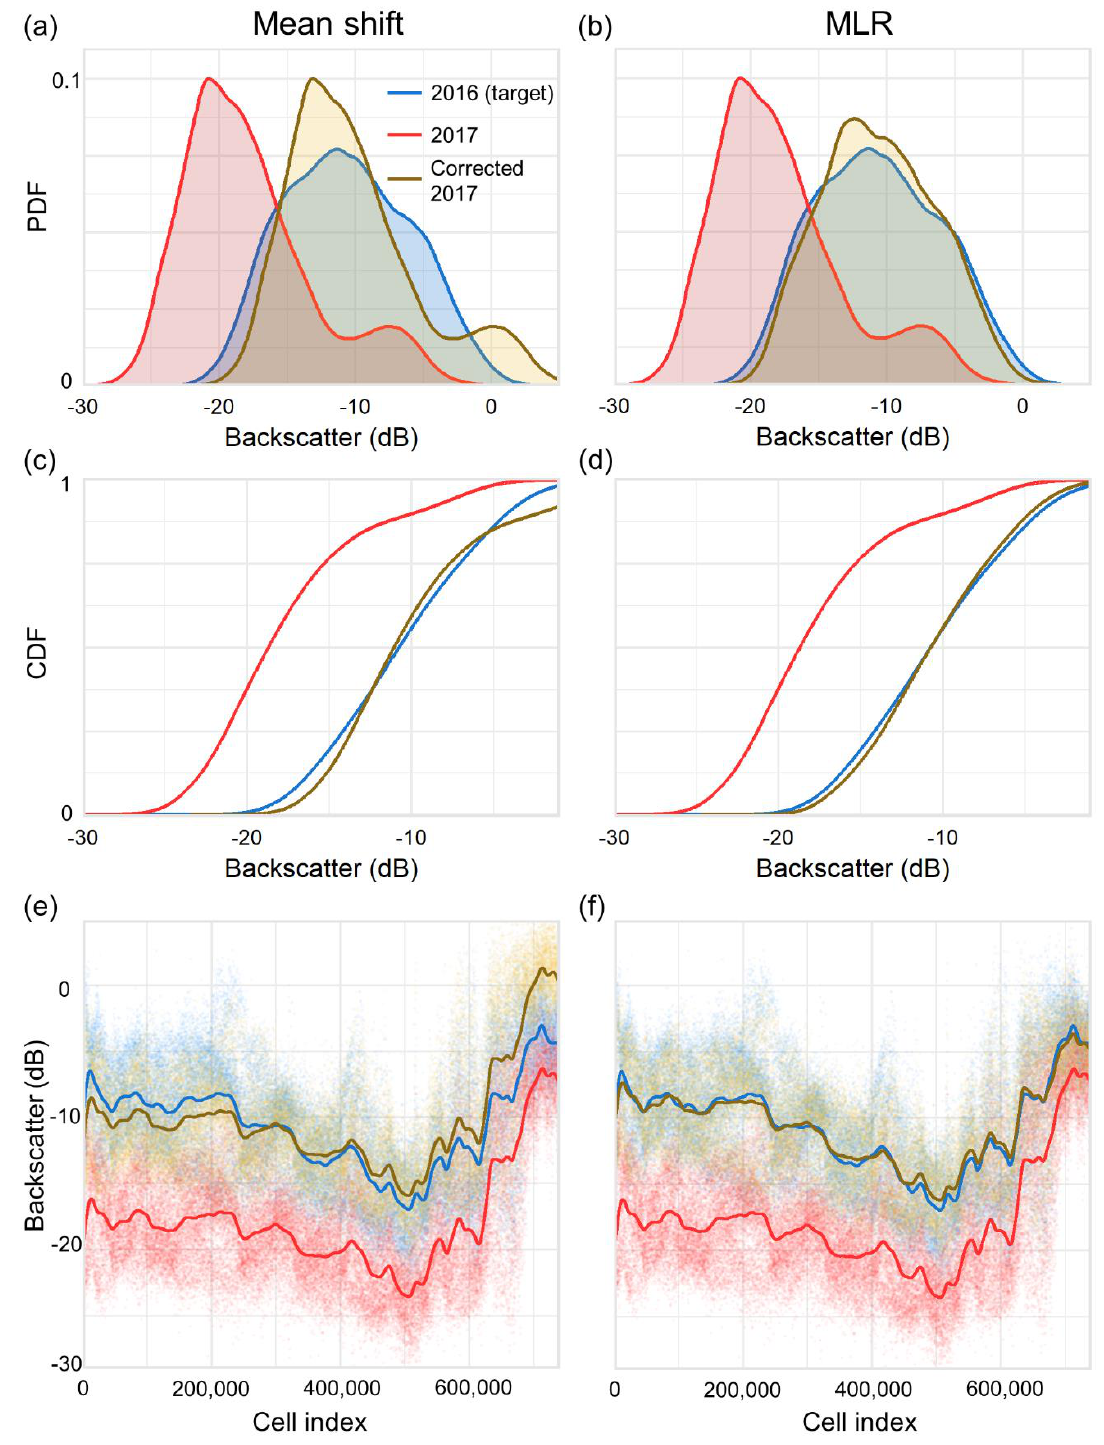
Figure 8. Bedford Basin inter-year 100 kHz test data comparison. Probability density functions (PDFs) of ( a ) mean backscatter, and ( b ) MLR shifts; cumulative distribution functions (CDFs) of ( c ) mean backscatter, and ( d ) MLR shifts; distribution of backscatter values with first order LOESS curves for ( e ) mean backscatter, and ( f ) MLR shifts, plotted by cell index on the x -axis, in which the rasters are read (north to south).